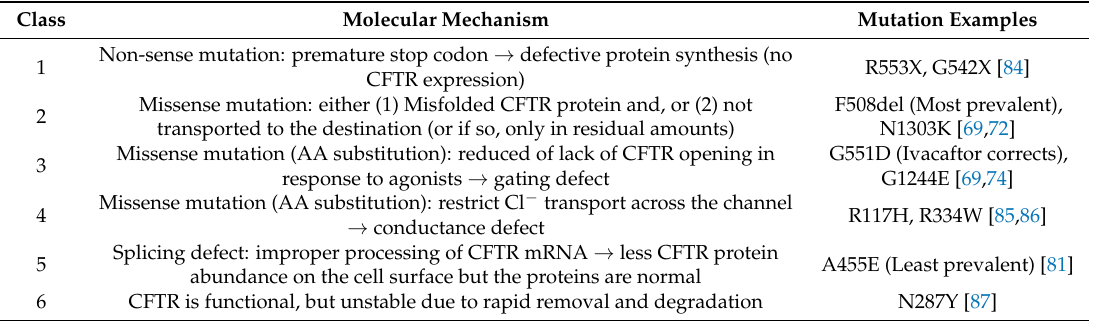
Table 1. Classes of CFTR mutations and molecular